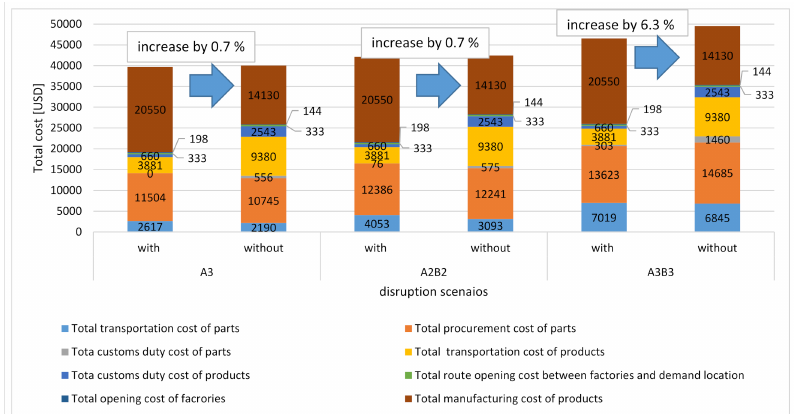
Figure 9. Cost breakdown in scenarios with and without factory